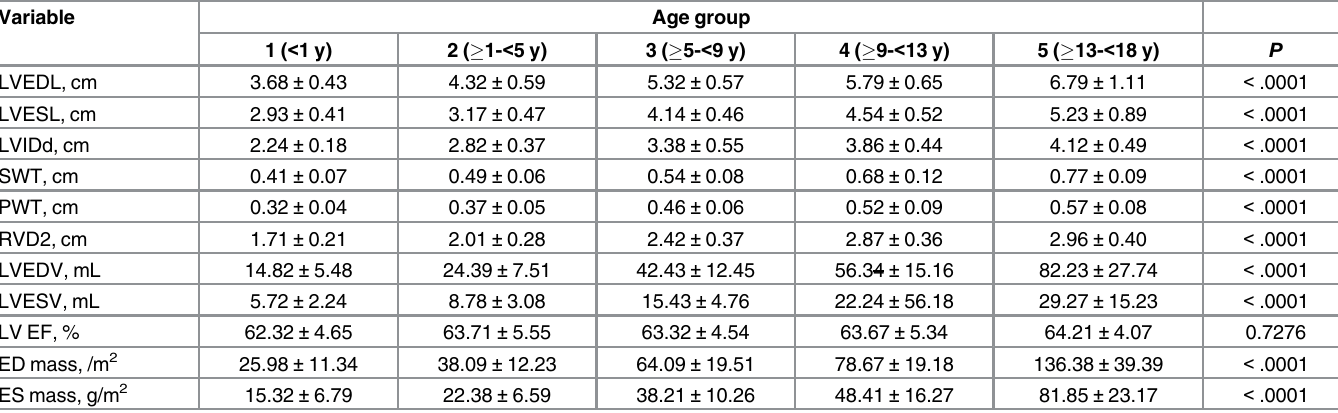
Table 2. Conventional echocardiographic